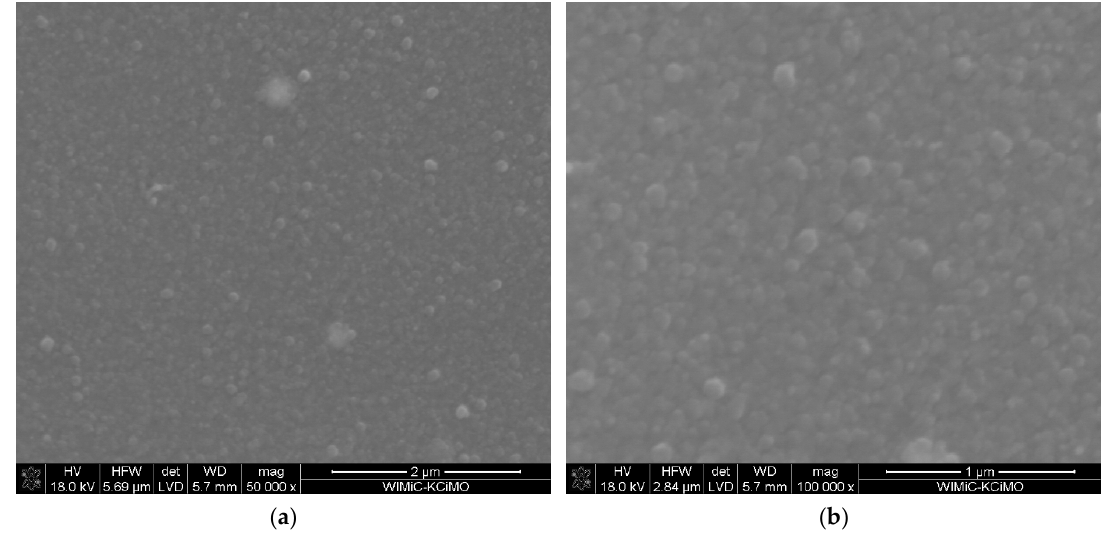
Figure 2. Microstructure of the layer deposited at temperature of 600 °C on tubular substrate without the presence of air at different magnification: 50,000× ( a ) and 100,000× ( b ). The content of Sc(tmhd) 3 in the gas mixture: 28 mol.%. Total gas pressure: 10 5 Pa. Synthesis time: 20 min.